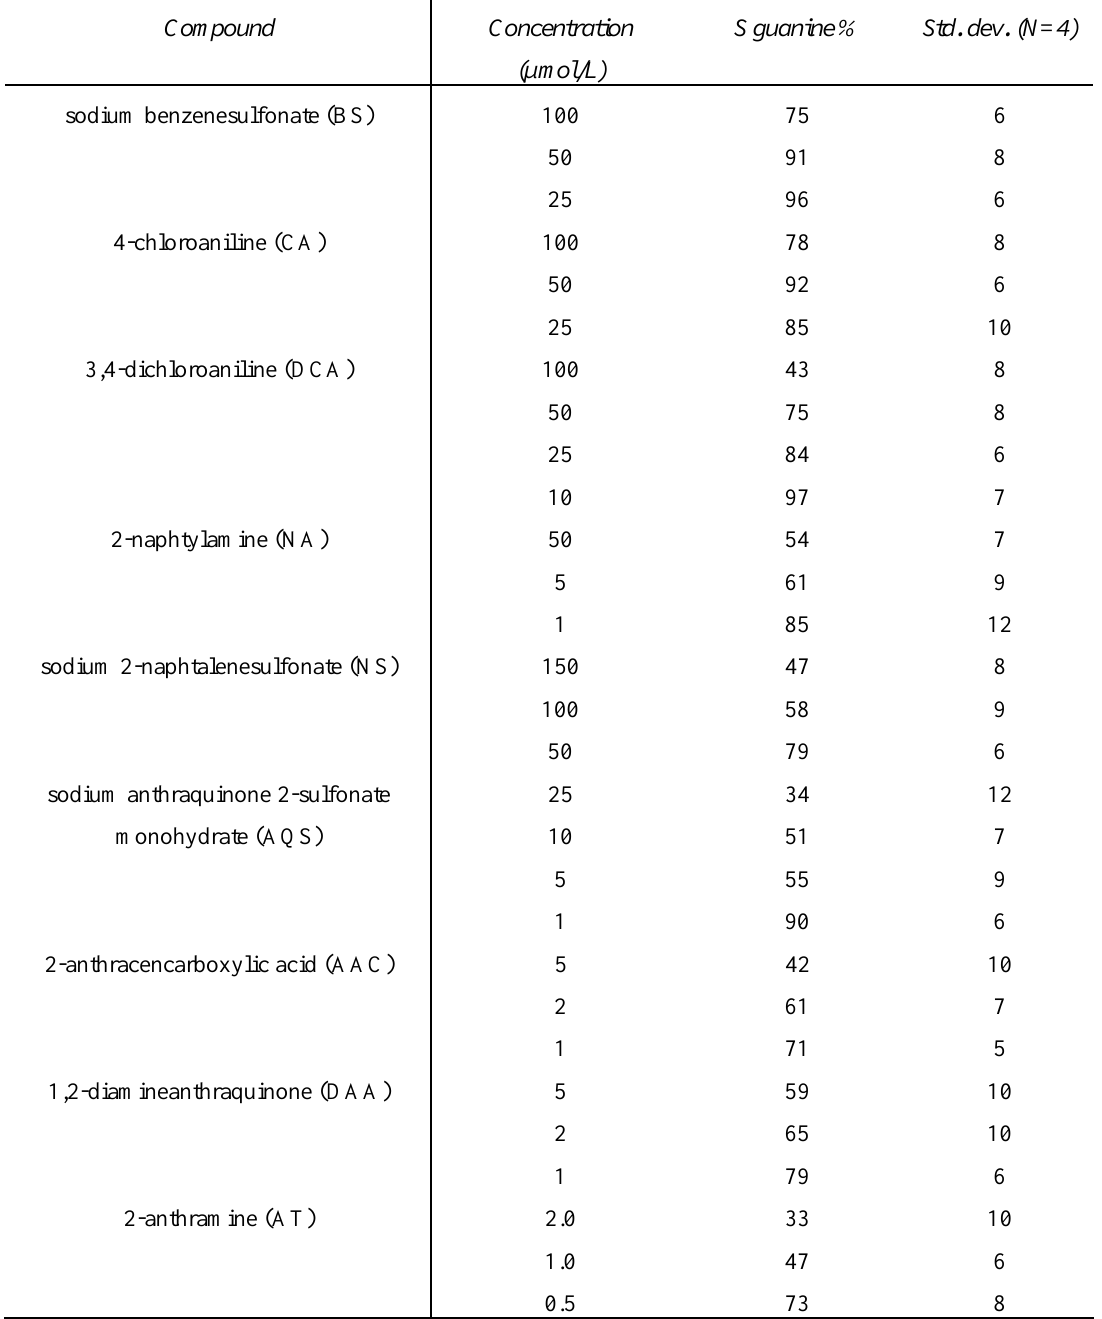
Table 1. DNA biosensor results for benzene, naphthalene and anthracene derivatives standard solutions present in ACNA area. Experimental conditions as in Figure